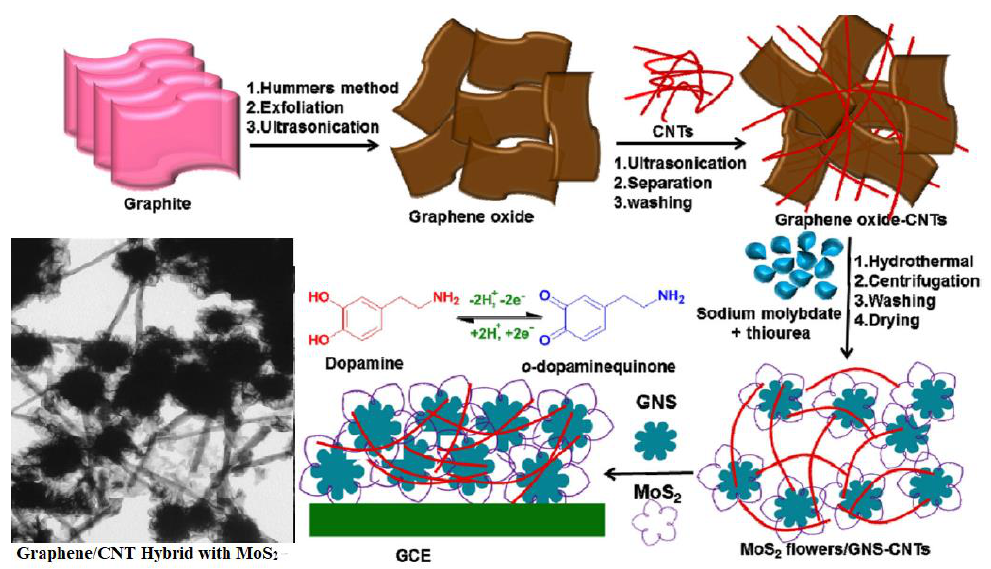
Figure 3. Functionalization strategy for Graphene oxide / CNT by MoS 2 nanoparticle formation (Reproduced with permission, modified picture of our own published work) .